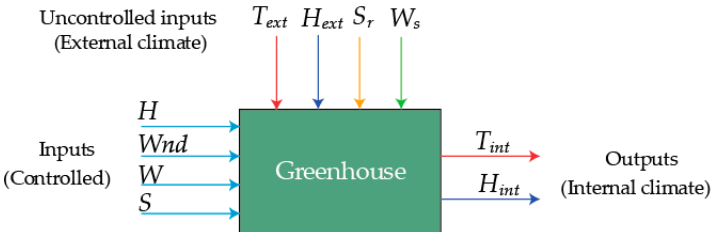
Figure 1. Schematic representation of a greenhouse ( T ext , external temperature; H ext , external humidity; S r , solar radiation; W s , wind speed; H , heating; Wnd , window opening state; W , watering; S , shading; T int , internal temperature; H int , internal humidity) based on [31].